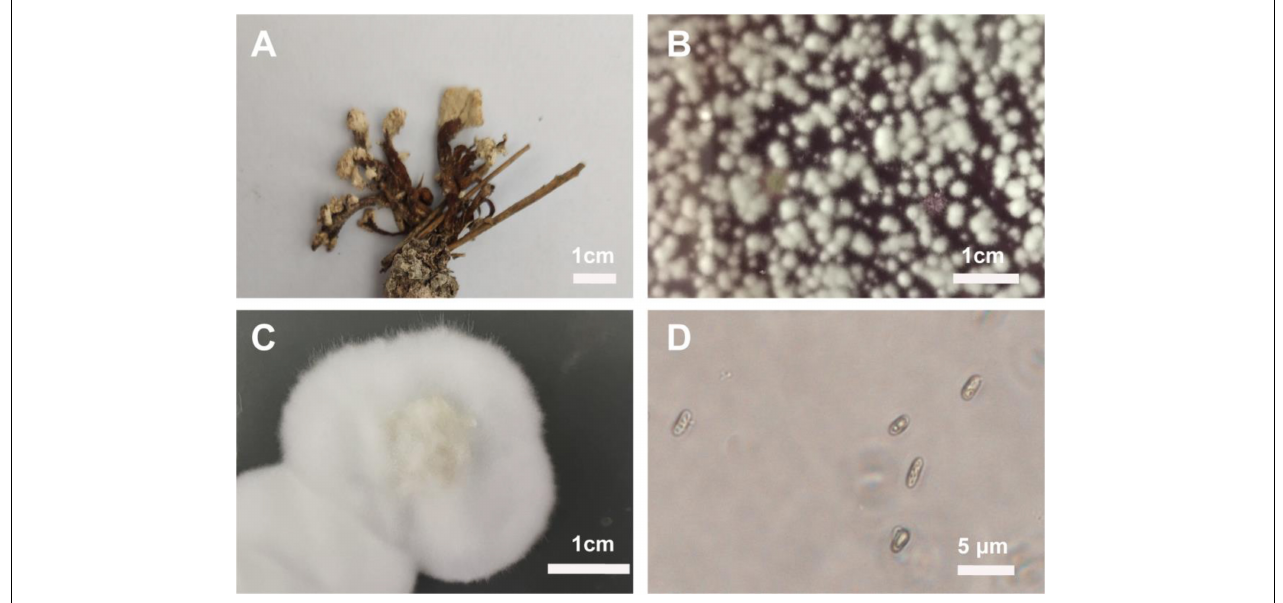
FIGURE 5 | Characteristics of the Cordyceps cicadae strain AH10-4 isolated from the coremium. (A) The coremium of wild cicada flower. (B) Rose bengal agar (RBA) plate coated with spore suspension from the coremium. (C) Colony of AH10-4 cultured on potato-dextrose agar (PDA) plate. (D) Dark-field optical micrograph showing the spore morphology of